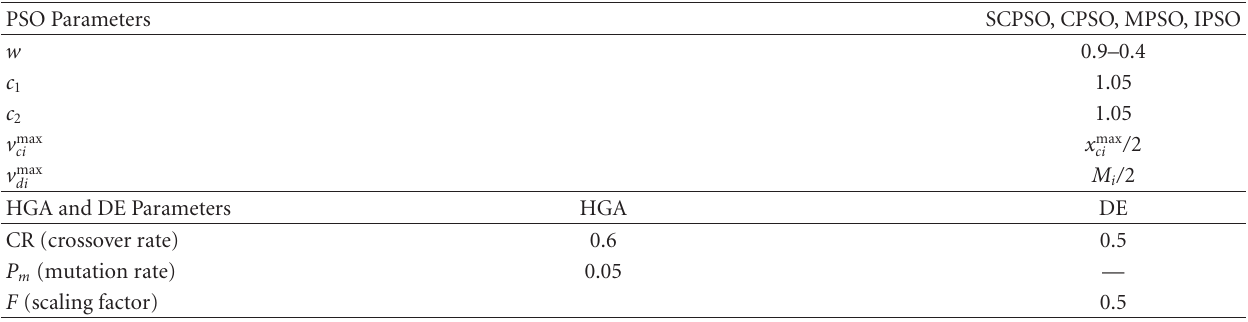
Table 4: Parameters of proposed algorithms.